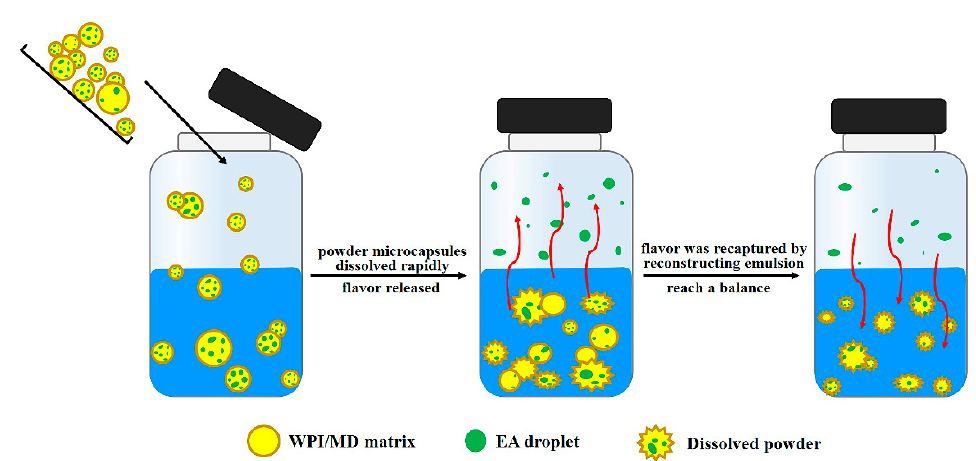
Figure 9. Schematic diagram of ethyl acetate (EA droplet) release when the powdered microcapsules using the wall materials whey protein and maltodextrin (WPI/MD matrix) are dissolved.